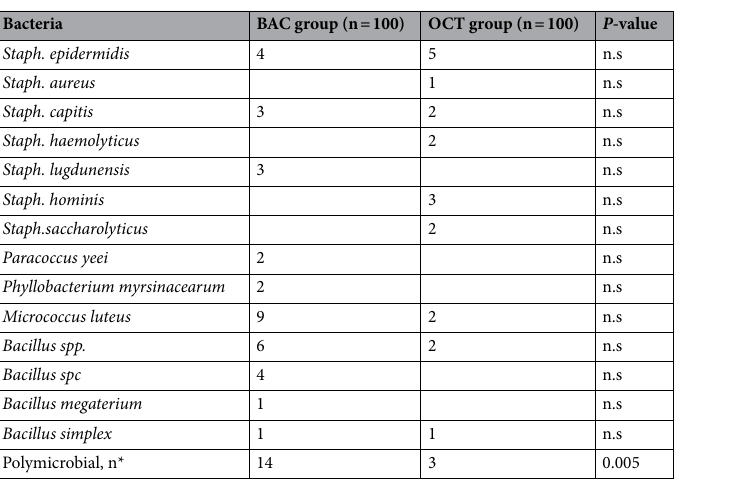
Table 4. Bacterial growth after skin cleansing with the alcohol-based antiseptic with additional benzalkonium chloride (BAC group) and the antiseptic with additional octenidine dihydrocloride (OCT group). *More than one different bacterial species grown from cutis and subcutis. N.s. = not